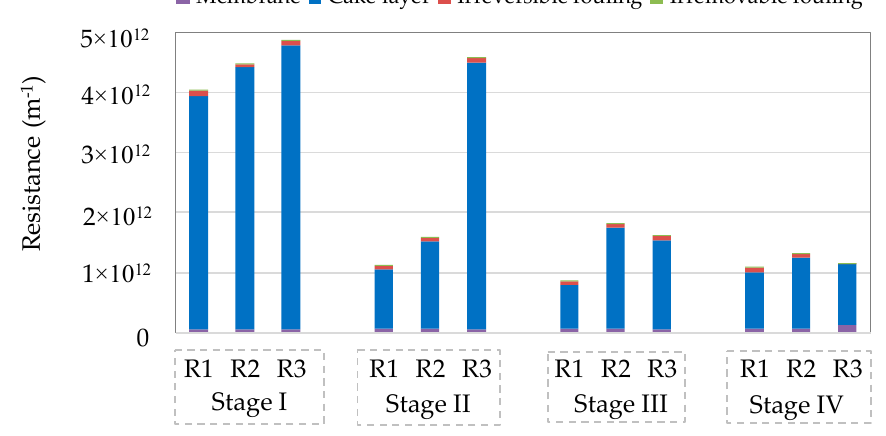
Figure 3. Fouling resistance distribution in the GDM reactor. To make a fair comparison, the normalized stable flux (J (22°C, 0.25m) ) and averaged permeability were calculated and are described in Figure 4. In Stage I (i.e., the constant water head), the normalized stable fluxes in the three GDM reactors were relatively comparable, at 1.82, 1.64, and 1.67 LMH for R1, R2, and R3, respectively. With variable